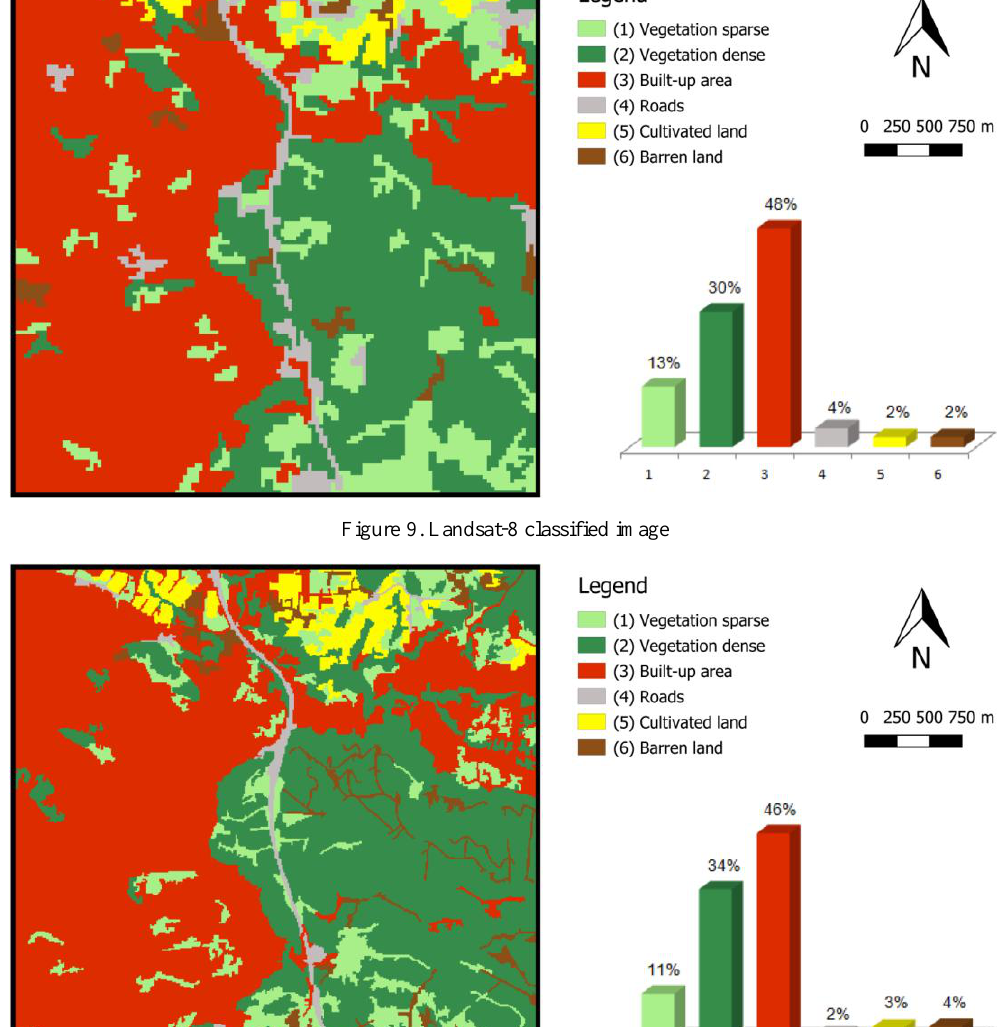
Figure 10. Sentinel-2A classified